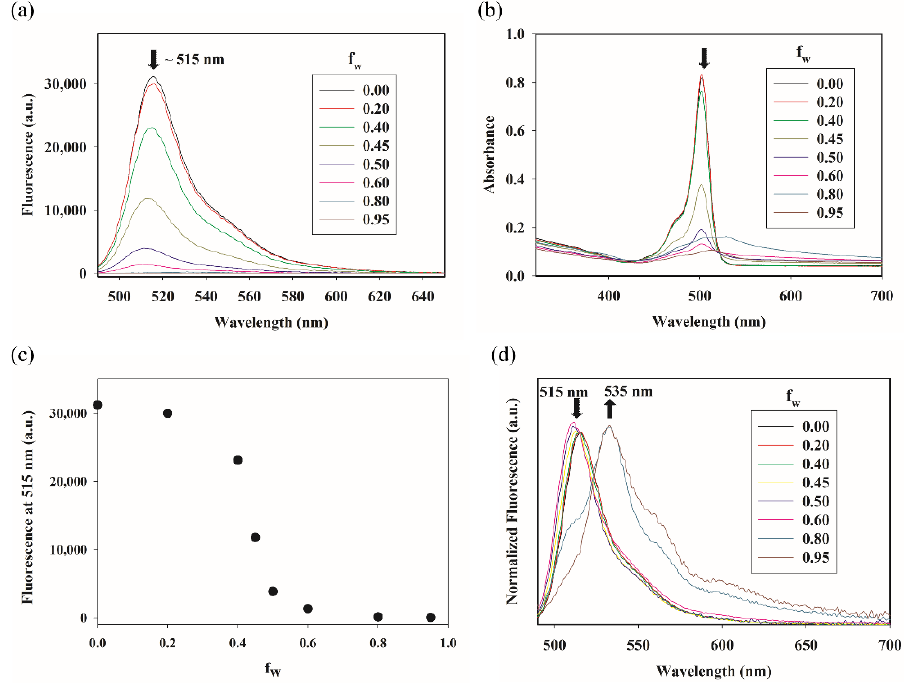
Figure 2. Fluorescence and absorption spectra of p-MB in DMSO–water mixture. ( a ) Fluorescence spectra of p-MB (50 µM) in DMSO solution with varying fractions of water (f w ). ( b ) Absorption spectra of the solutions in ( a ), retaining the same color coding. ( c ) Fluorescence intensity of 50 µM p-MB at 515 nm as a function of solvent composition. ( d ) Fluorescence spectra from ( a ) were normalized to have the same intensity to illustrate the red shift in the p-MB emission maximum in mostly aqueous solution vs. DMSO. Arrows in ( a , b , d ) denote the direction of change at the specified wavelengths as f w increases. The excitation wavelength for the emission spectra was 470 nm. a.u. = arbitrary unit.